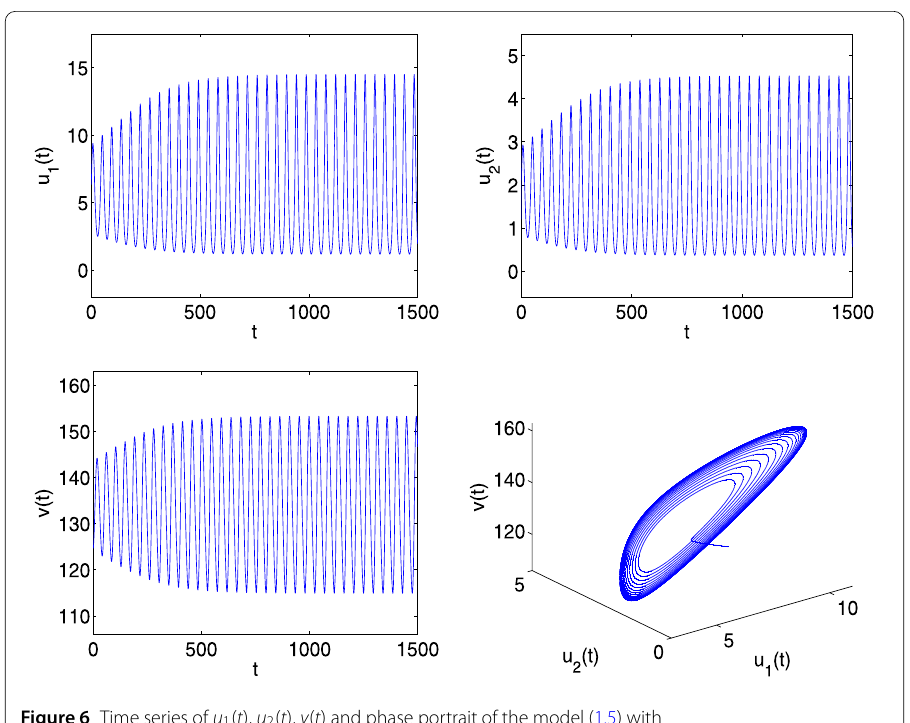
Figure 6 Time series of u 1 ( t ), u 2 ( t ), v ( t ) and phase portrait of the model (1.5) with τ = 0.5 > τ 0 = 0.1509514710143546. An orbit from the initial condition ( u 1 (0), u 2 (0), v (0)) = (7,1.2,125) located in a sufficiently small neighborhood of the equilibrium E 2 (5.303571428572600,1.650000000000400, 133.712142857161200) converges to a periodic solution. The simulation results indicate that the equilibrium